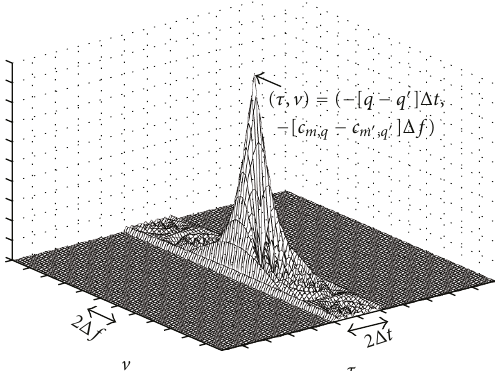
Figure 3: Cross-ambiguity between subpulses, | G m , m (cid:6) , q , q (cid:6) ( τ , ν ) | .